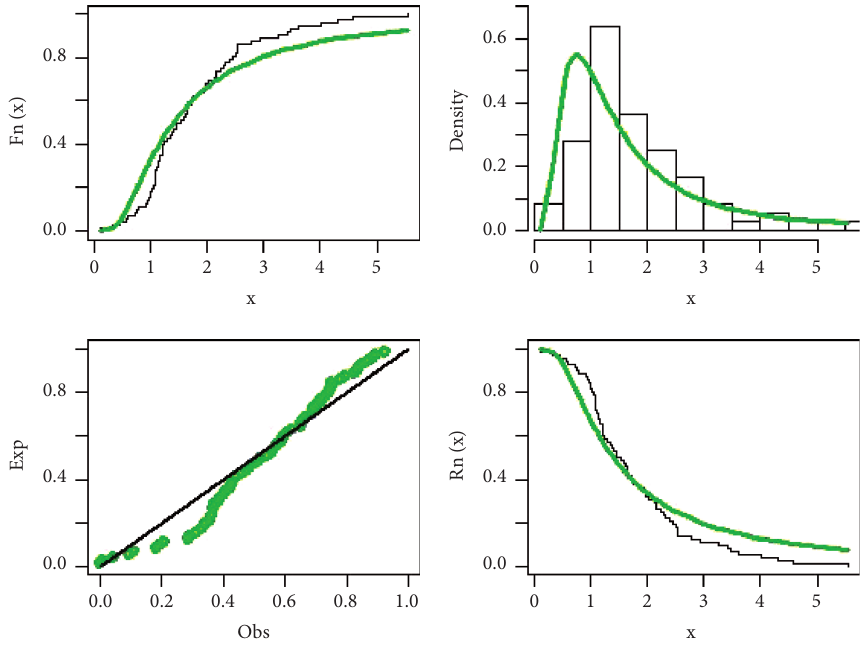
Figure 6: The estimated pdf, ecdf, esf, and pp plots for the TLIL model for dataset II. Table 10: Summary of goodness-of-fit statistics for dataset II.